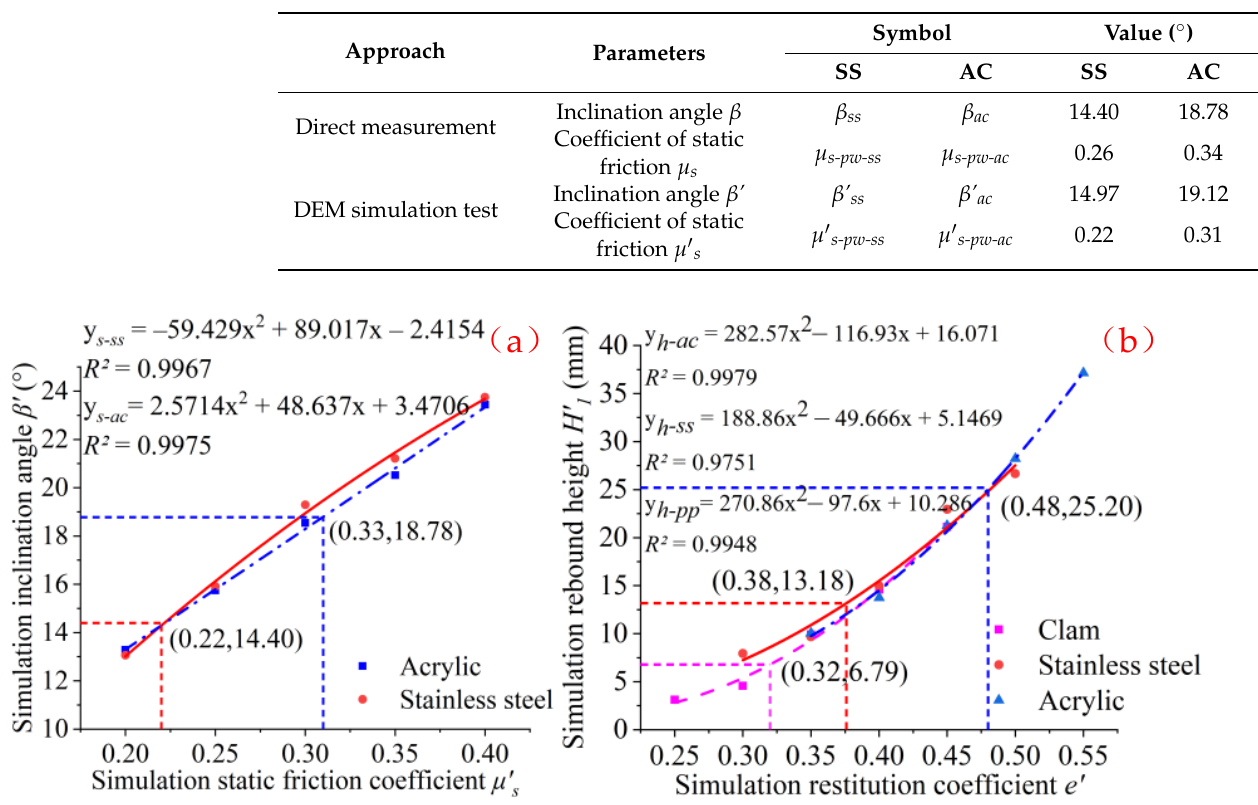
Table 2. Particle–wall coefficient of static friction ( µ s-pw ) for SS and AC.